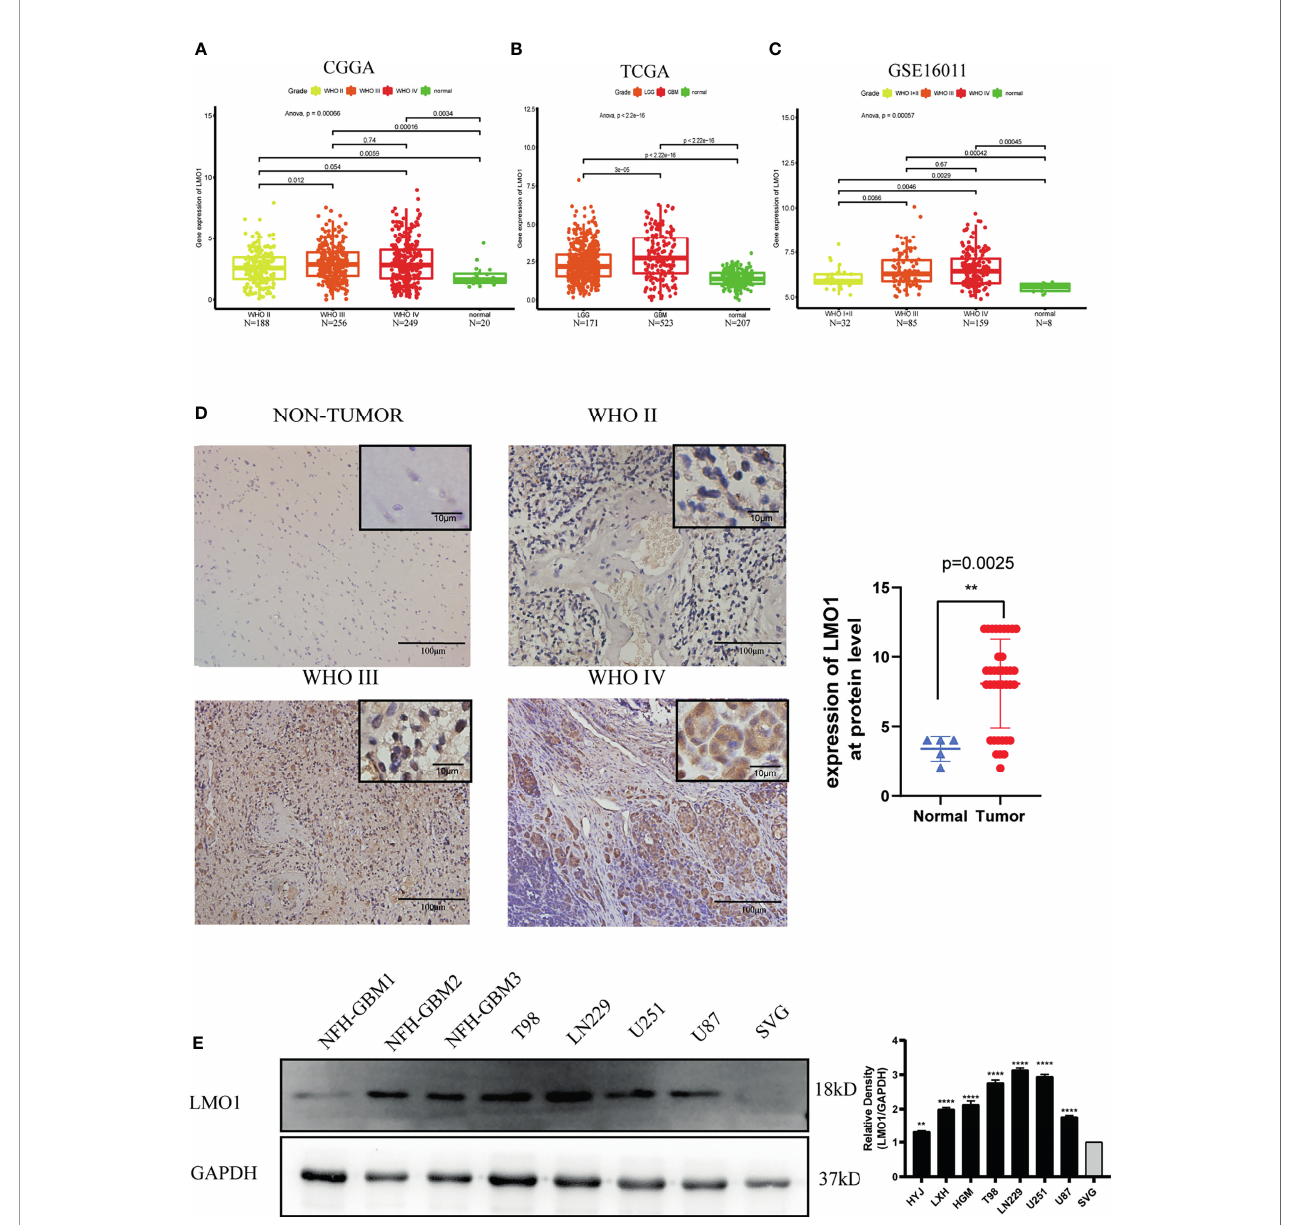
FIGURE 1 | Increased LMO1 expression is related to a more malignant glioma. (A) The expression levels of LMO1 in 693 tumor tissues and 20 normal tissues were analyzed by CGGA. (B) The expression levels of LMO1 in 694 tumor tissues and 207 normal tissues were analyzed by TCGA. (C) The expression levels of LMO1 in 276 tumor tissues and 8 normal tissues were analyzed by GSE16011.Tukey ’ s Honest Signi fi cant Difference (HSD) test is used in (A – D) Representative immunohistochemistry (IHC) staining for LMO1 in non-tumor and different grade glioma samples. Scale bars=100 m m (main images) and 10 m m (insets).Comparison of LMO1 IHC staining scores between non-tumor and glioma samples. Unpaired Student ’ s t-test were used for statistical analysis. (E) WB analysis of LMO1 in the canonical and patient- derived GBM cell lines. GAPDH was used for normalization. One-way ANOVA tests were used for statistical analysis. **p < 0.01. ****p <